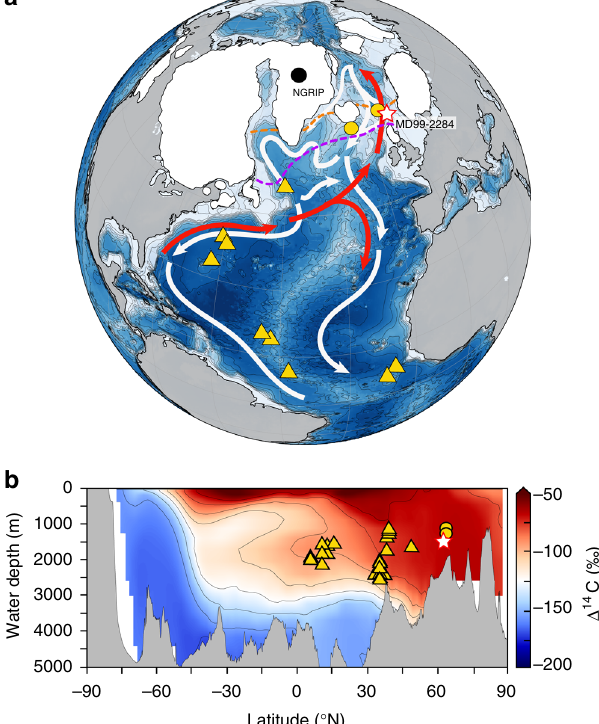
Fig. 1 Site location. a Location of core MD99-2284 (star), NGRIP ice cores (black circle) 101 , and other sediment cores (yellow circles) and deep-sea corals (yellow triangles) discussed in this study. The white areas indicate the extent of Northern Hemisphere ice sheets at 12500 years BP 102 . Red and white arrows show warm Atlantic in fl ow to the Nordic Seas and main bottom current pathways in the northern North Atlantic. Simulated winter (March, purple) and summer (September, orange) 50% sea-ice cover fraction during GS-1 (12,500 years BP) 103 is also shown. b Meridional section of radiocarbon concentration within the Atlantic Ocean (averaged over 0 – 40°W) from a pre-industrial control simulation using a